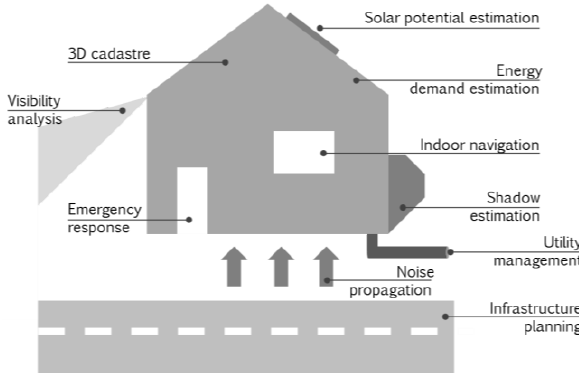
Figure 2. Use cases for 3D building models (adapted from Biljecki et al.